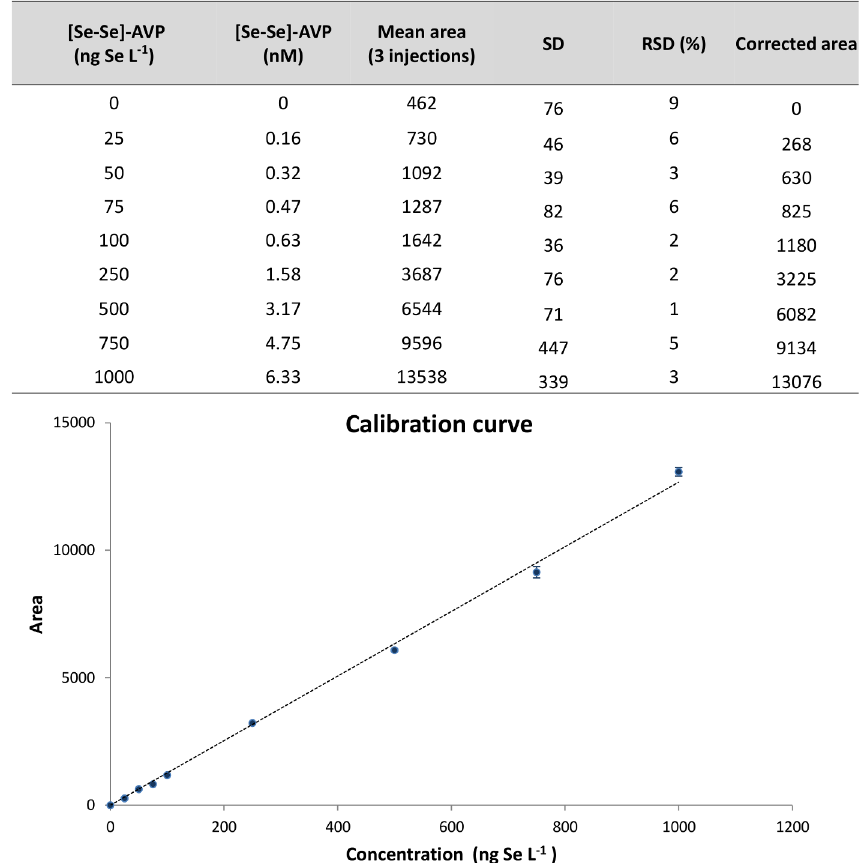
Fig 5. Calibration curve with 78 Se